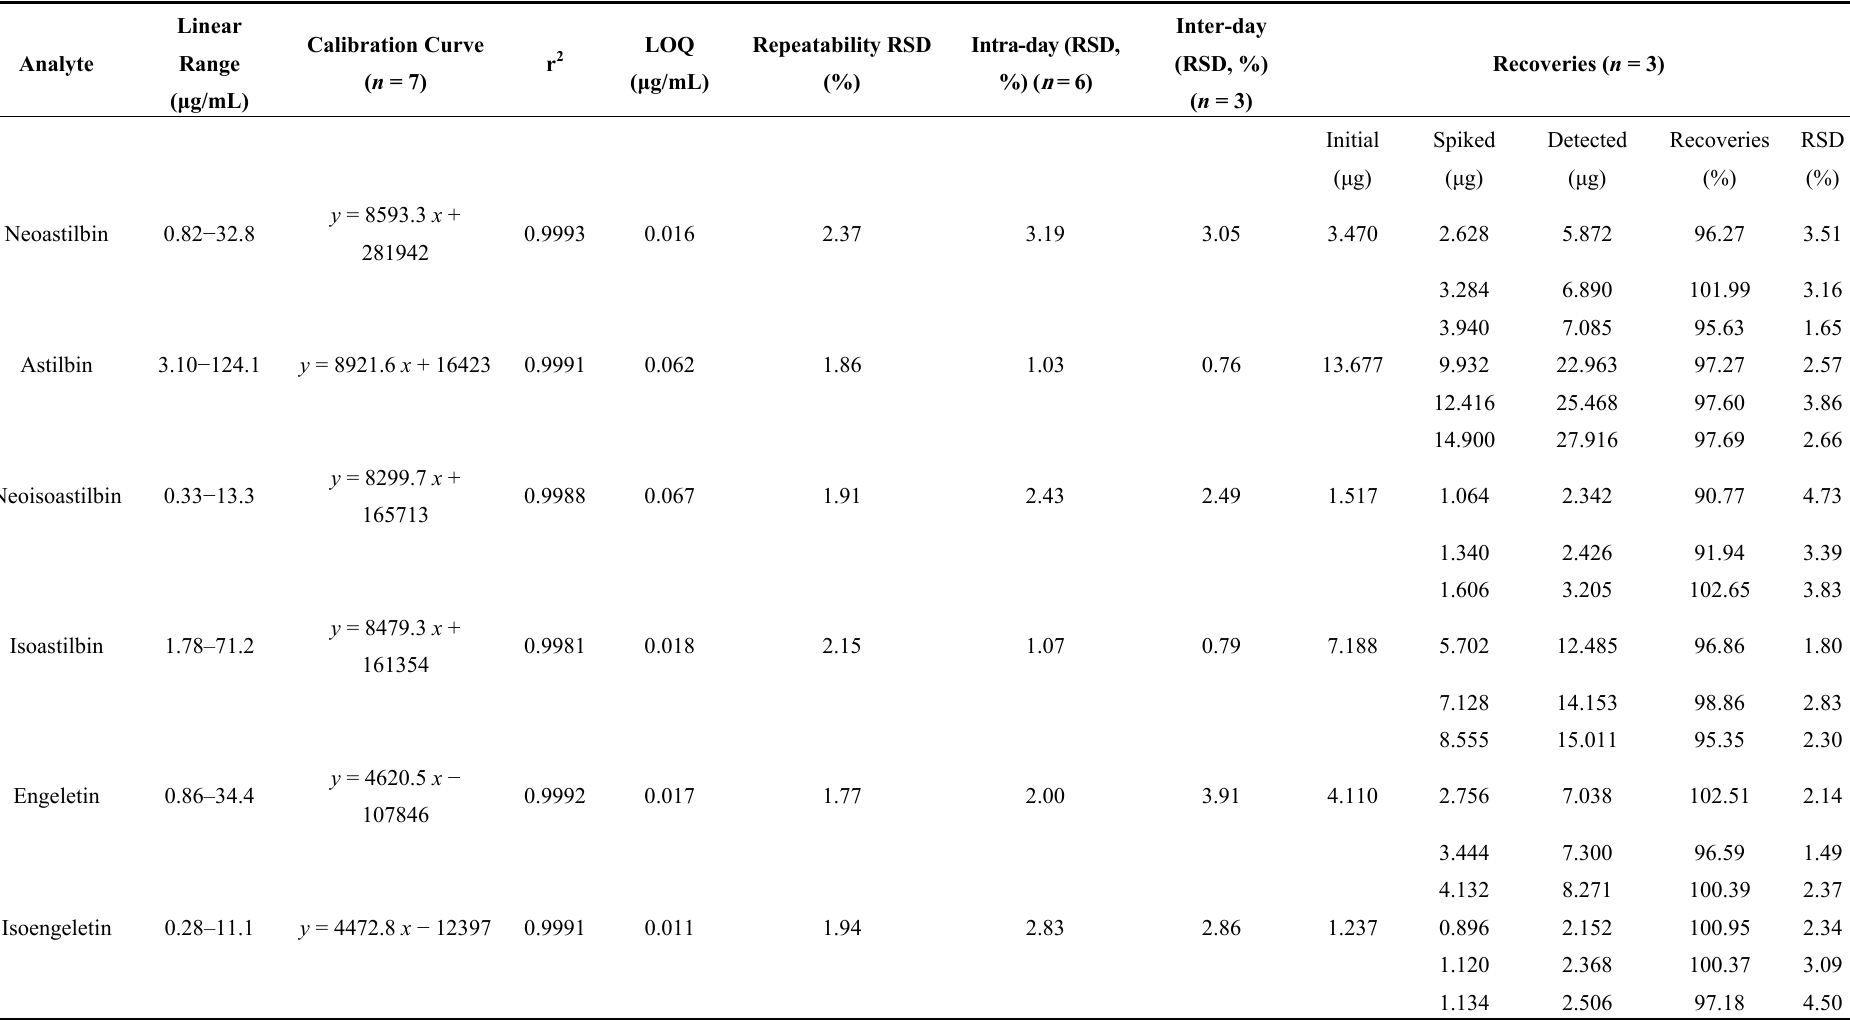
Table 2 Summary of calibration curves, linear range, LOQ, repeatability, intra-day and inter-day precisions and recoveries for six analytes analyzed with the LC-MS